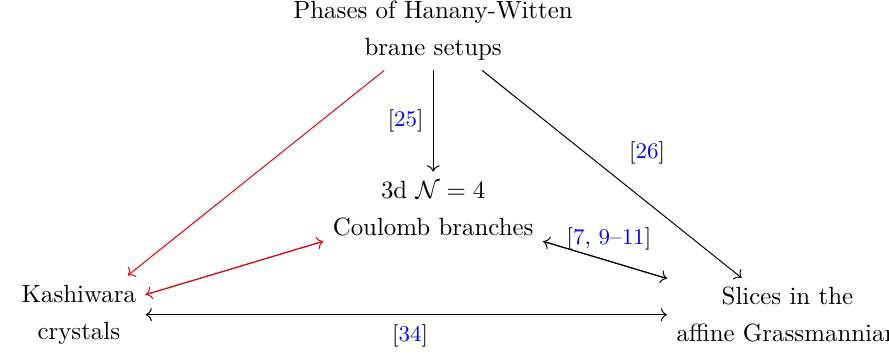
Figure 2 . Summary of the topics covered in the body of the paper, and their web of